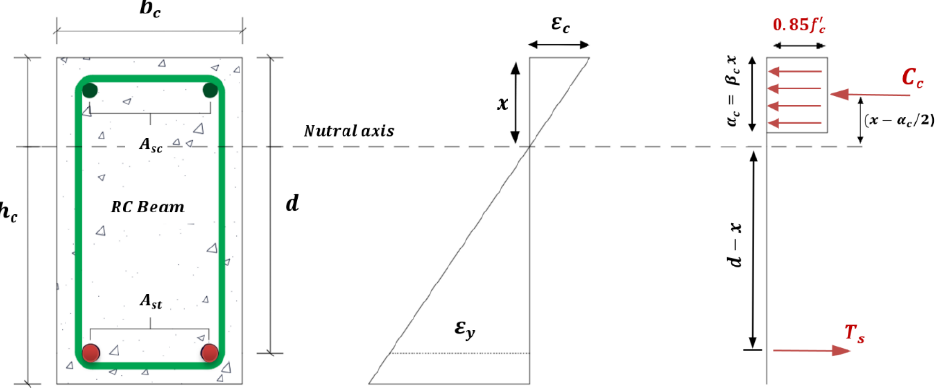
Figure 16. Strain and stress distribution diagrams used for analytical modeling.